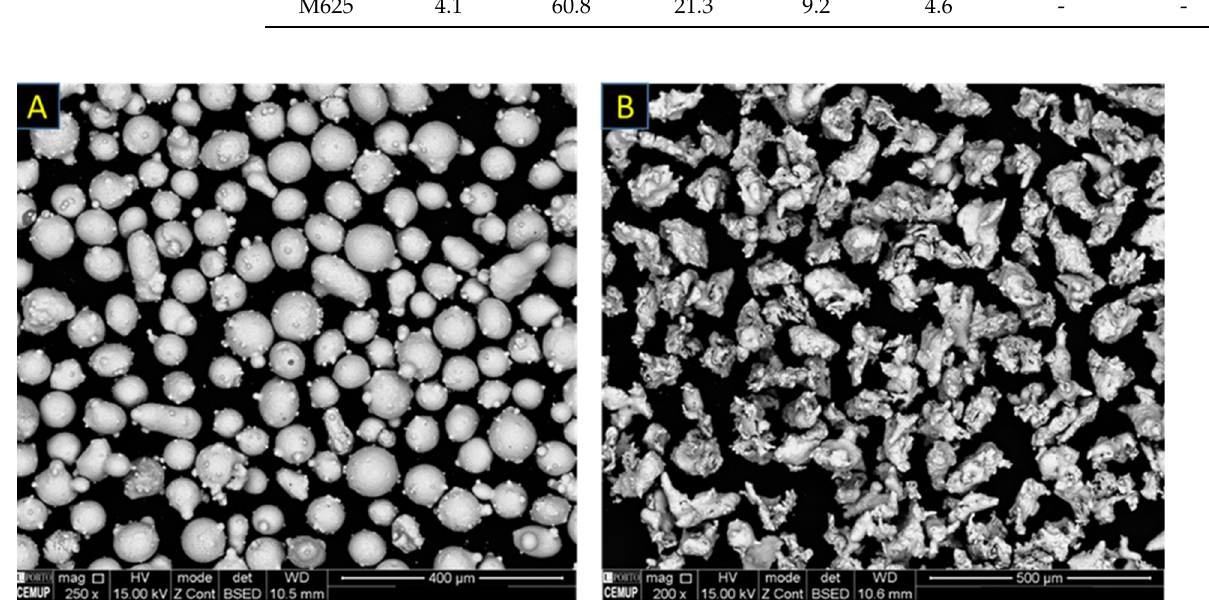
Figure 1. Morphology of ( A ) M625 and ( B ) M42C powders illustrated by SEM/BSE technique.